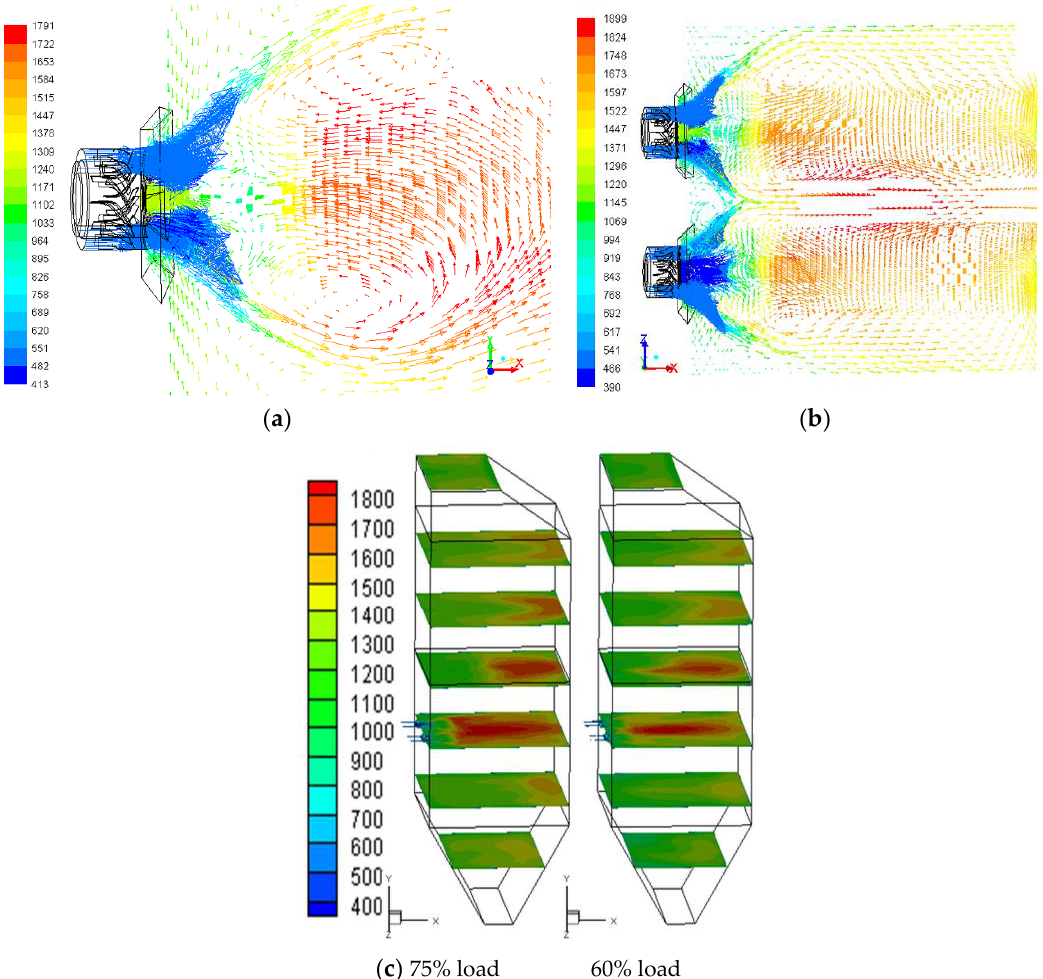
Figure 5. Velocity vector colored by temperature in a longitudinal section of the primary zone at z = 0.85 m ( a ) and in the horizontal section y = 4.35 m ( b ), and gas temperature contour on different level sections of the furnace ( c ) with the variation of load (K).